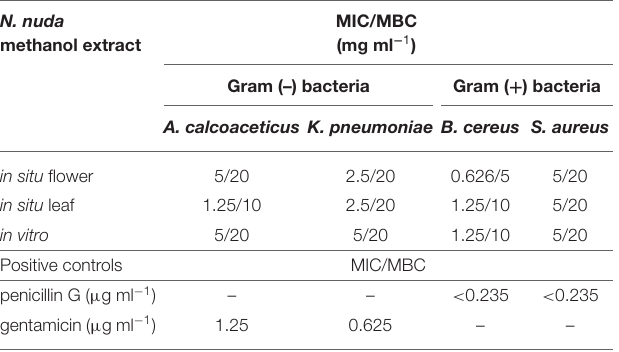
TABLE 3 | Antibacterial activity of N. nuda methanol